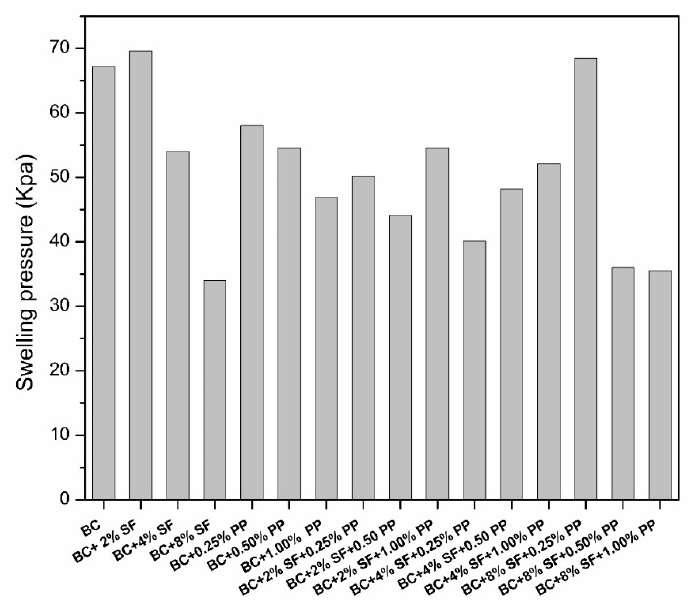
Figure 1. Combined upward swelling pressure curve with and without reinforced expansive soil. The reduction in upward swelling pressure was observed with the inclusion of silica fume